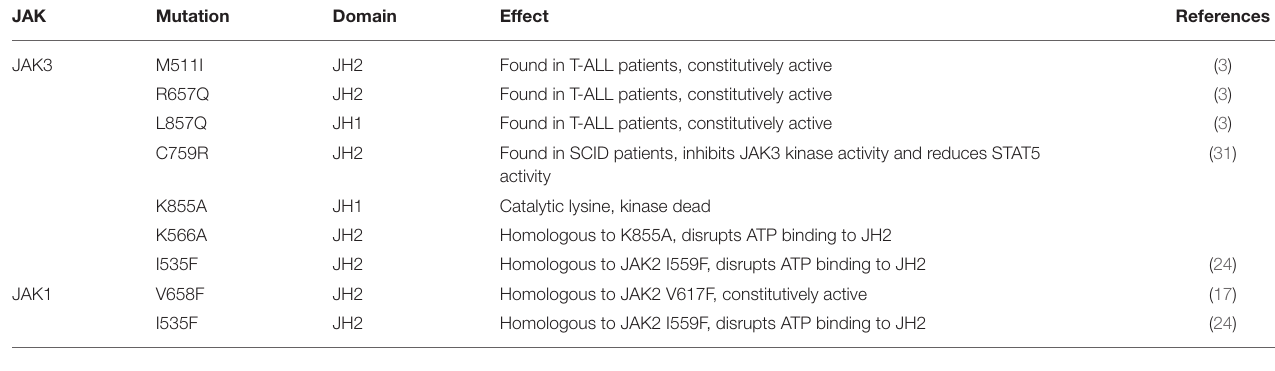
TABLE 1 | Mutations used in this study.